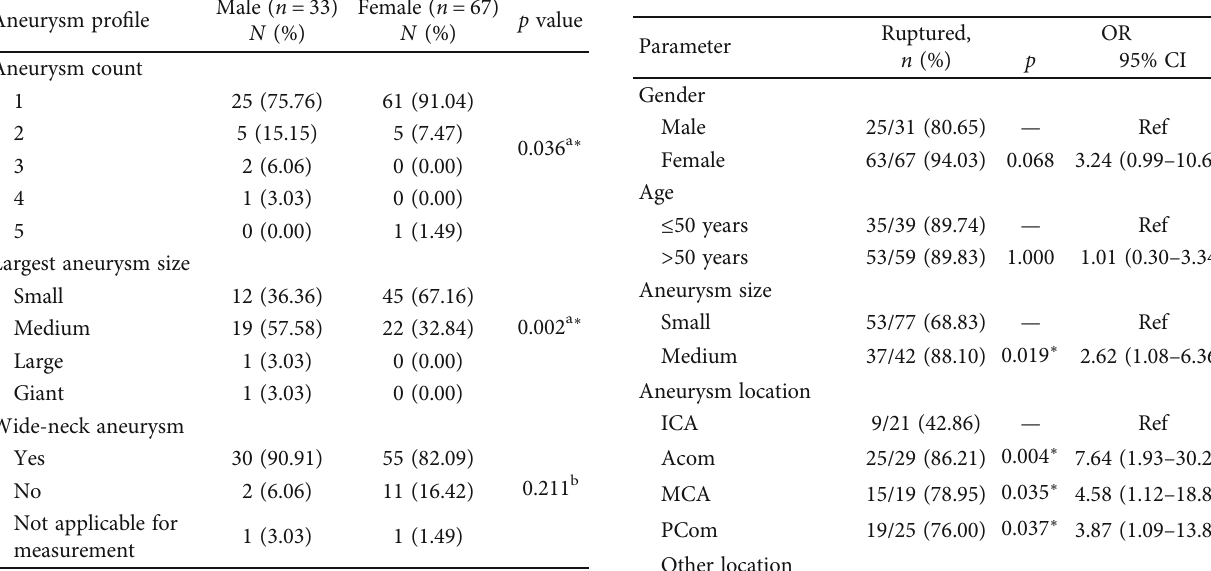
Table 4: Bivariate analysis of all intracranial aneurysm and rupture